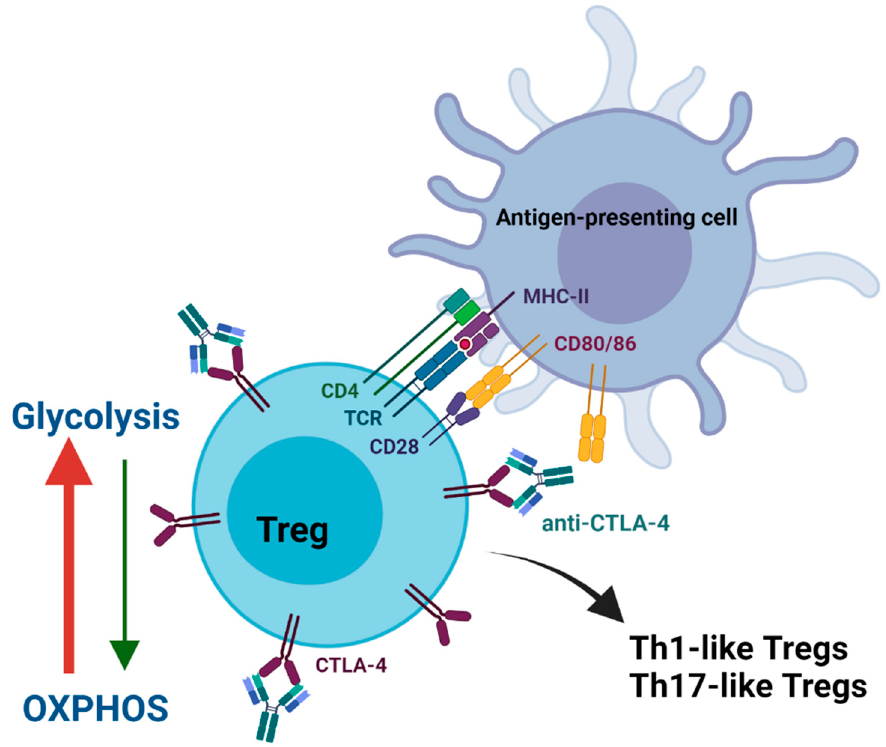
Figure 3. Alteration of Treg metabolism and plasticity. Anti-CTLA-4 allows CD28 on Tregs to engage with CD80/86 on antigen-presenting cells. Costimulatory signaling shifts the metabolism of Tregs from oxidative phosphorylation (OXPHOS) to glycolysis. Increasing glycolysis can functionally and phenotypically destabilize the immunosuppressive nature of Tregs. Tregs can adopt the pro-inflammatory characteristics of Th1 and Th17 cells to contribute to anti-tumor immune responses.